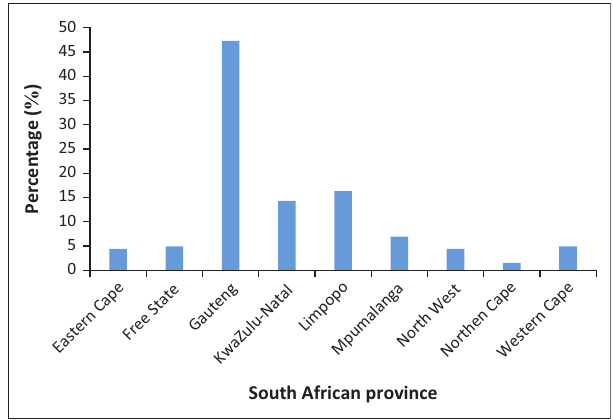
FIGURE 1: Distribution of respondents per province of South